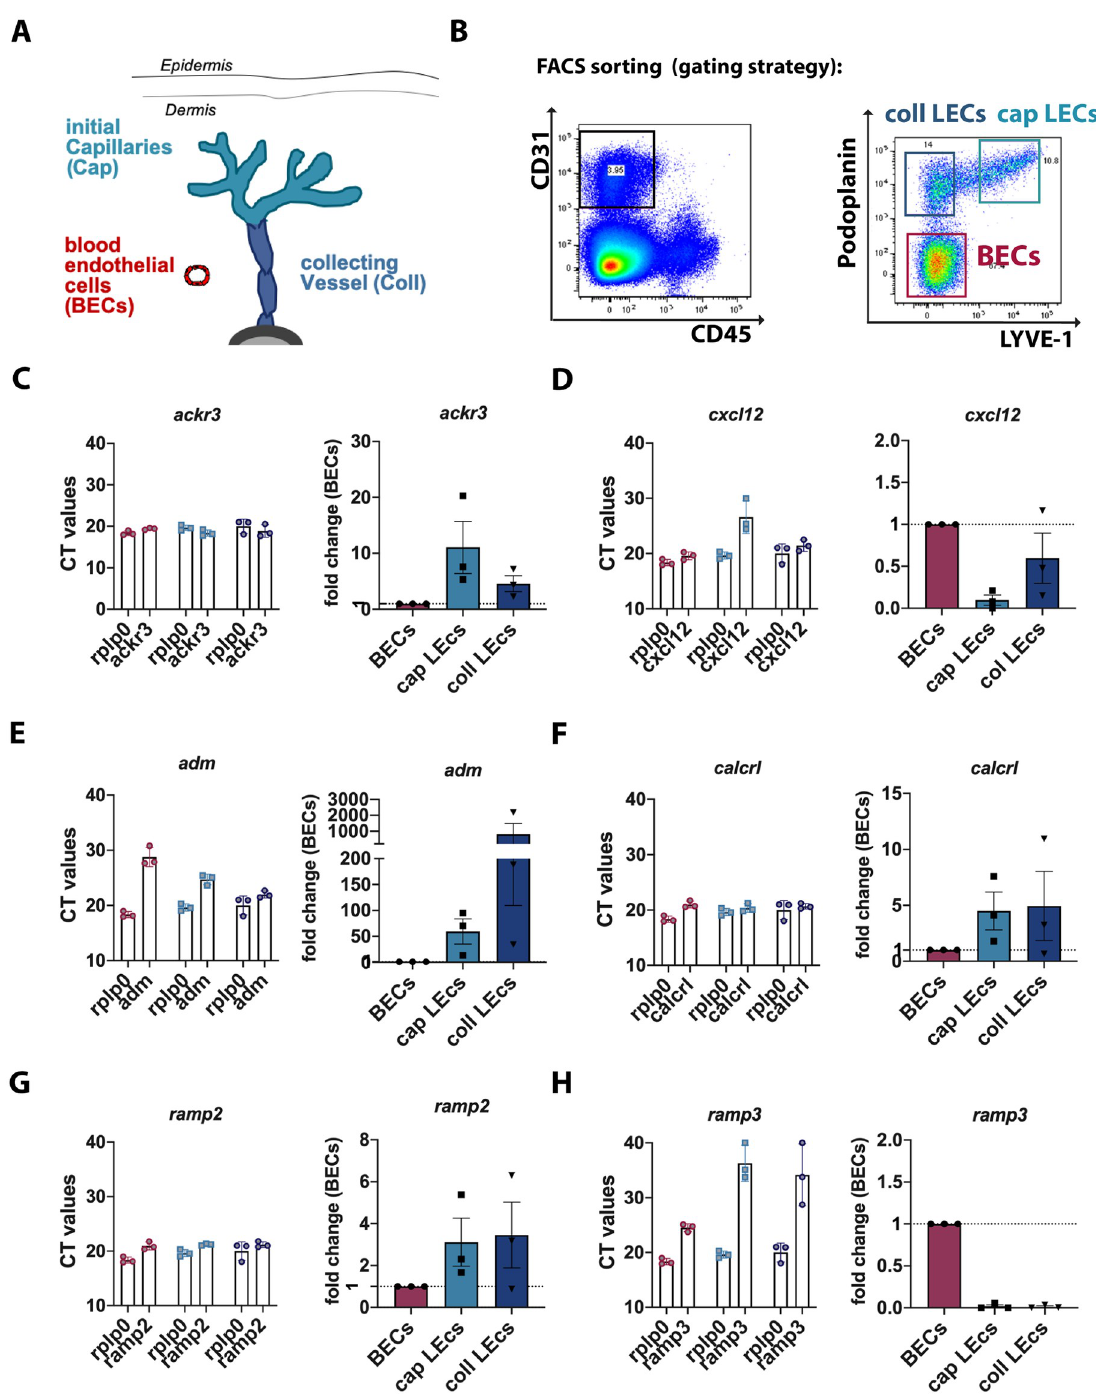
Fig 1. Gene-expression signature of ACKR3, CXCL12, AM, CALCRL, RAMP2 and RAMP3 in BECs, collLECs and capLECs isolated from murine ear skin. (A) Schematic localization of capLECs (cyan), collLECs (blue) and BECs (red) in afferent lymphatic vessels and blood vessels of the skin. (B) FACS sorting strategy: CD45 - negative cells were sorted according to the following strategy: CD31 + Podoplanin - LYVE - blood endothelial cells (BECs), CD31 + Podoplanin + LYVE - collector LECs (collLECs) and CD31 + Podoplanin + LYVE + capillary LECs (capLECs). (C-H) qPCR analysis performed on cDNA derived from FACS-sorted capLECs, collLECs and BECs. Each Fig shows CT values compared to the housekeeping gene rplp0 on the left, and the resulting relative mRNA expression of genes in capLECs and collLECs compared to BECs (set to one, dotted line), on the right. Results are shown for (C) ackr3 , (D) cxcl12 , ( E) adm , ( F ) calcrl (G ) ramp2 , and (H) ramp3 . Each data point represents the mean (mean ± SEM) of three independent qPCR replicates performed with cDNA of n = 3 samples, derived from 2 animals per sample.